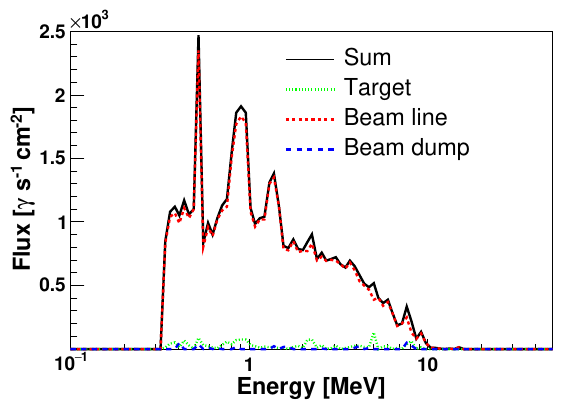
Figure 3. Same as in Figure 2, but for the simulated γ -rays en- ergy